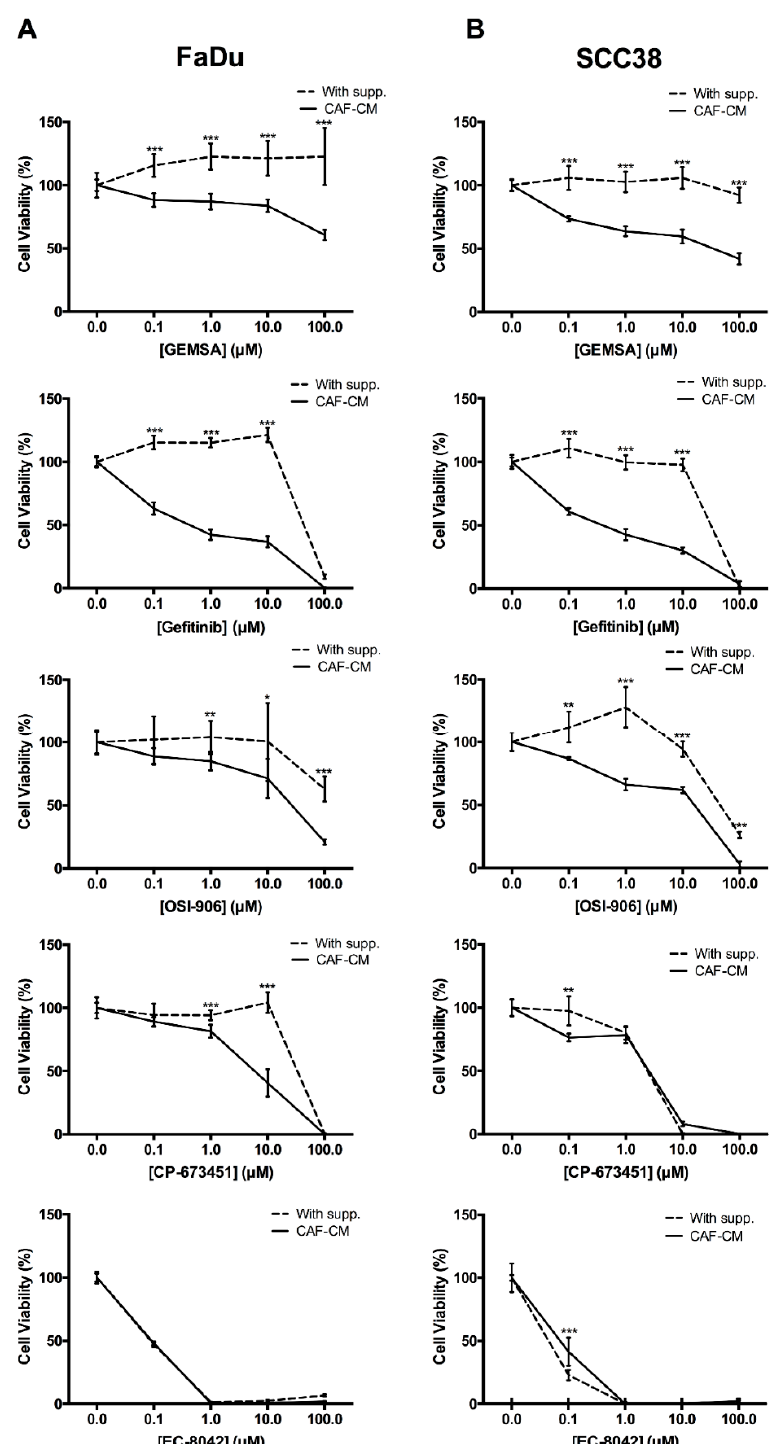
Figure 5. Effect of 2-guanidinoethylmercaptosuccinic acid (GEMSA), Gefitinib, OSI-906, CP-673451, and EC-8042 on CAF-CM-mediated anchorage-independent growth. ( A ) FaDu and ( B ) SCC38 cells were seeded in polyHEMA-coated plates and grown in CAF-CM or supplemented medium. After 24 h, cells were treated with increasing concentrations of the indicated drugs (GEMSA, Gefitinib, OSI-906, CP-673451, and EC-8042). Cell proliferation was estimated by tetrazolium-based MTS assay after 4 days. Data were normalized to the absorbance at day 0 and relative to control (vehicle-treated) cells. All data were expressed as the mean ± SD of at least three independent experiments performed in quadruplicate. * p < 0.05, ** p < 0.01 and *** p < 0.001 by Student’s t -test.